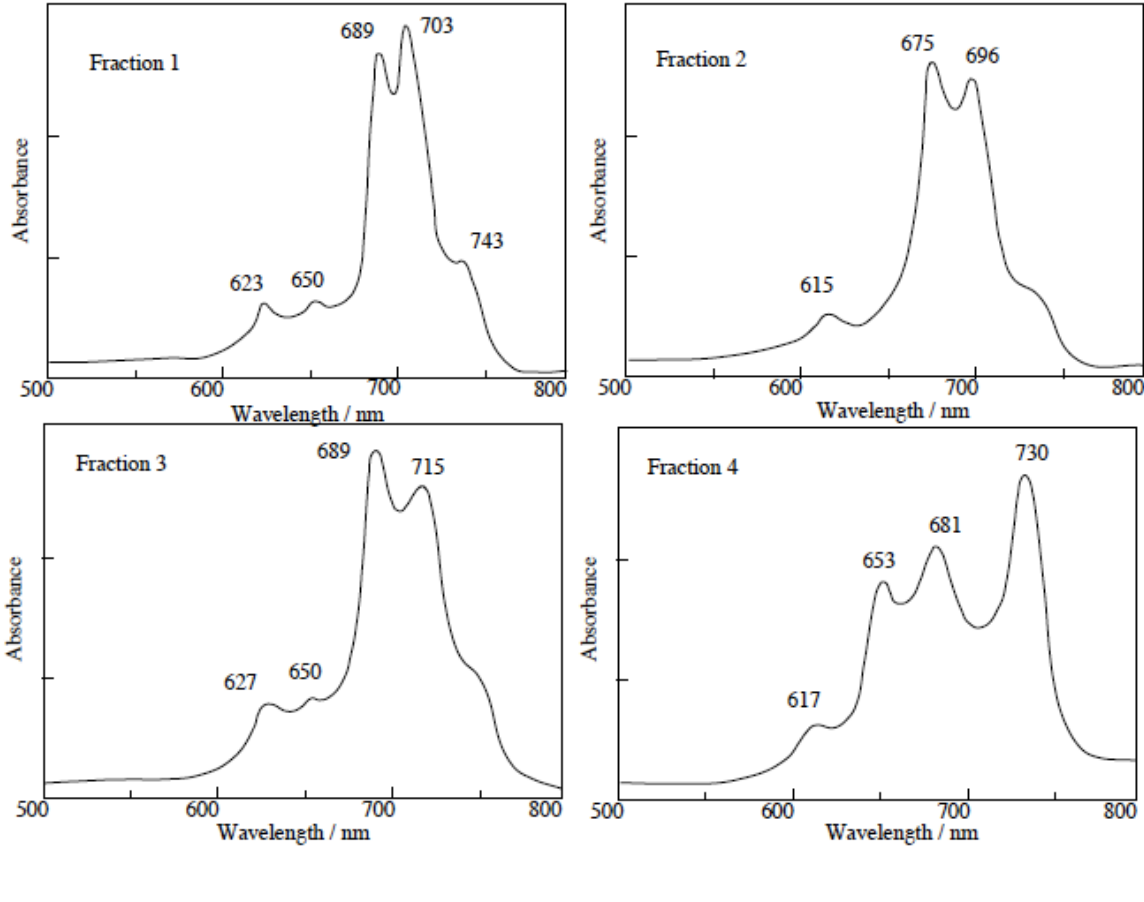
Figure 4. UV-Vis spectra of each regioisomer in 5c quaternized with DMS. The UV-Vis spectra of each quaternized compound was measured in Py